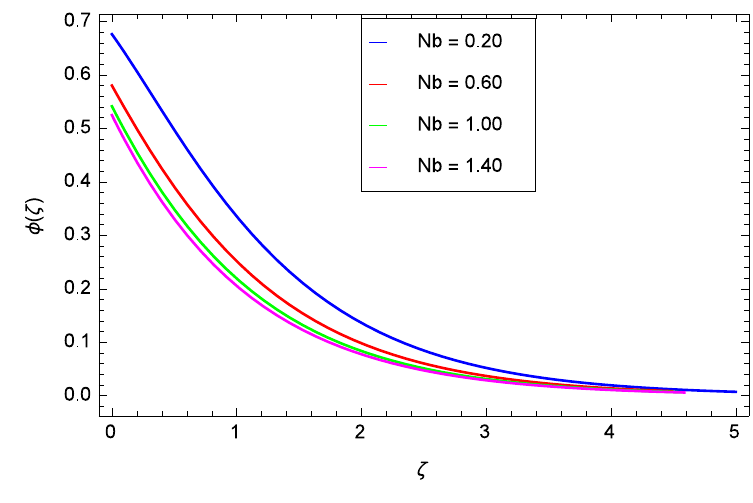
Figure 18. Influence of Nb on φ ( ζ ) .